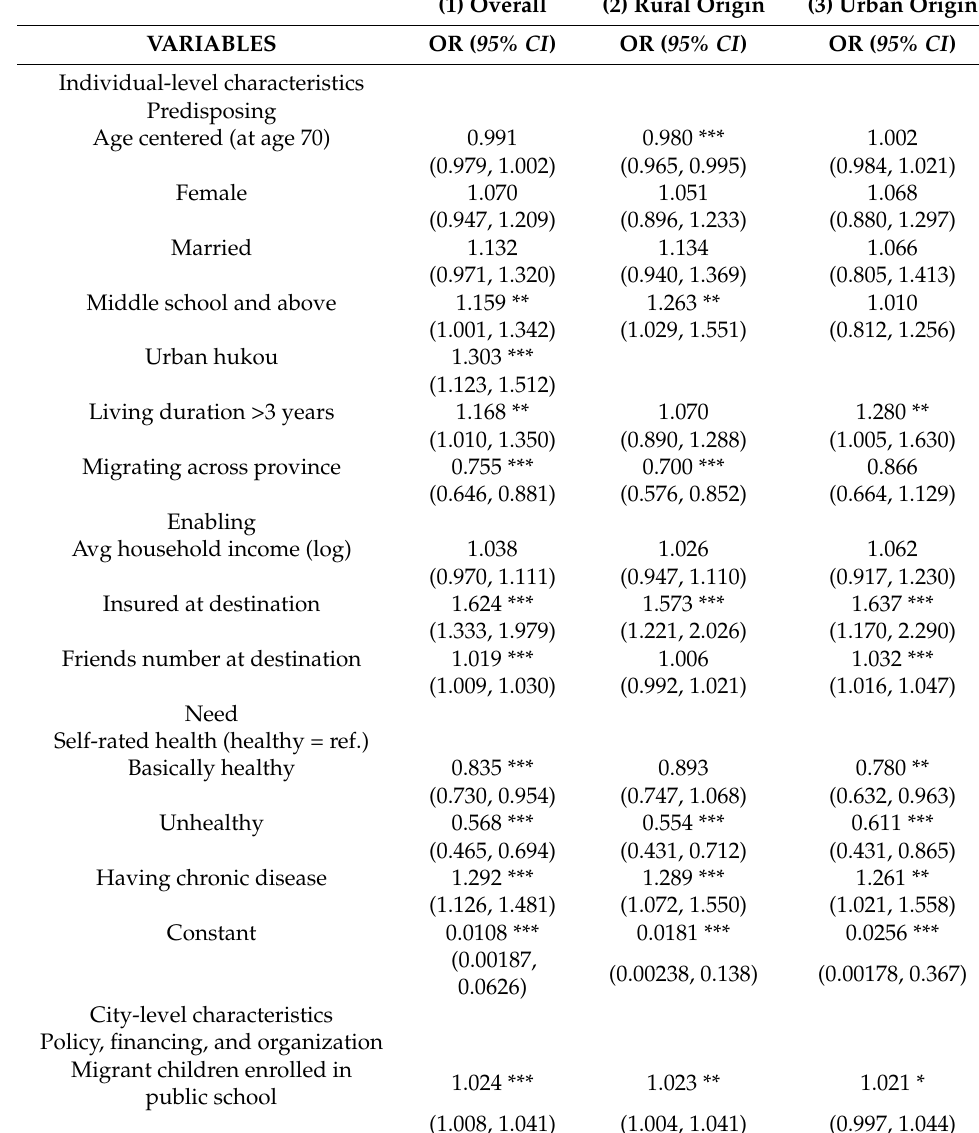
Table 3. Logistic regression of free medical examination on contextual and individual